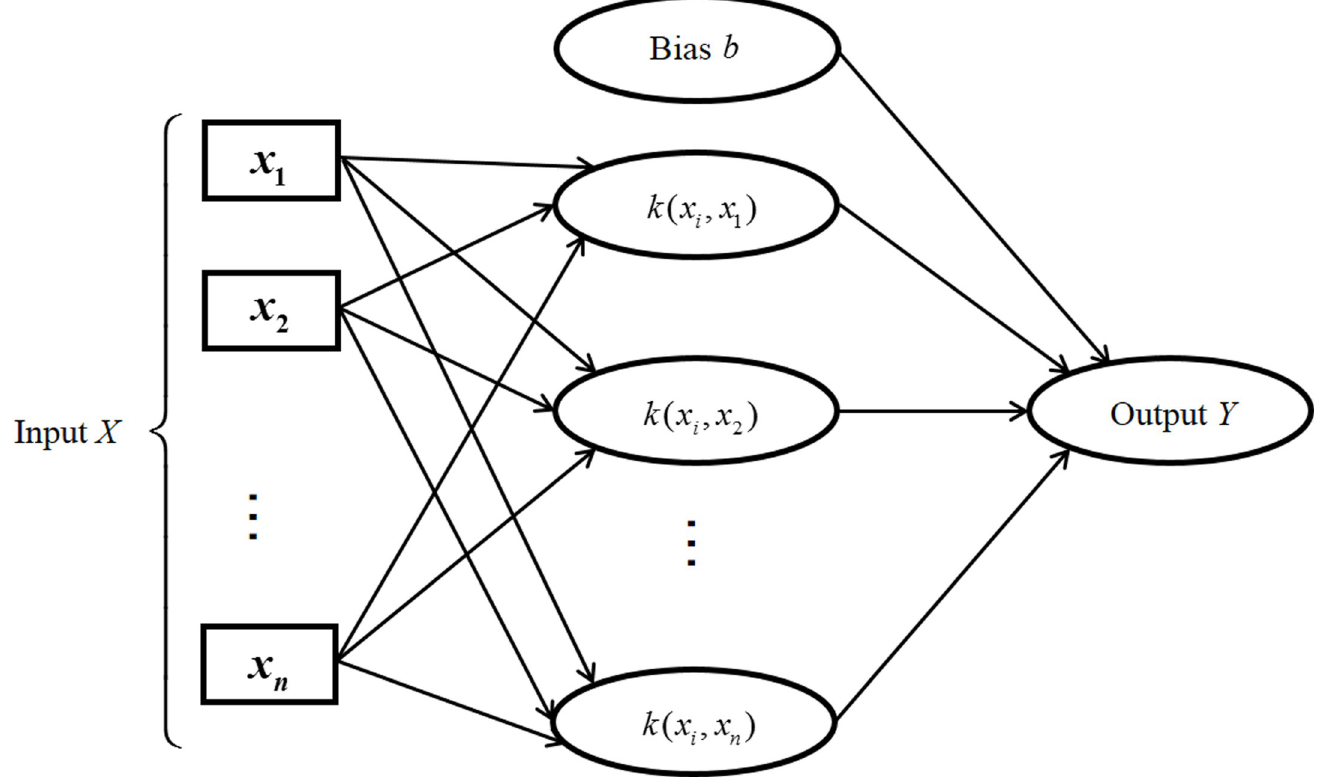
Fig 1. Support vector machine